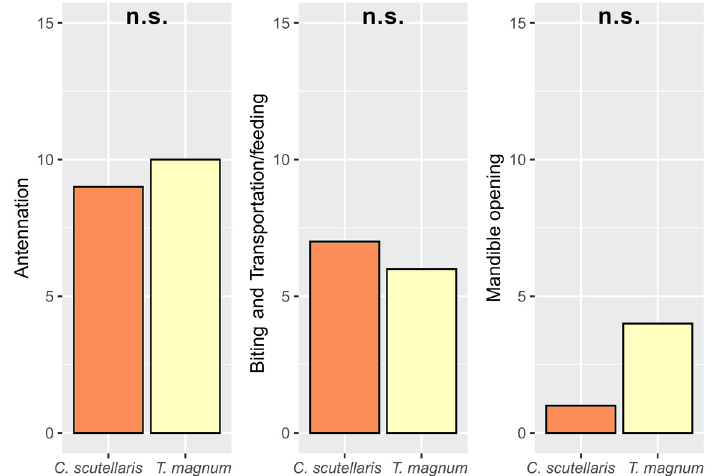
Figure 2. The interactions observed between the ants ( Crematogaster scutellaris and Tapinoma mag- num ) and the Cydia pomonella larvae. No statistically significant differences (n.s.) between the two ant species were